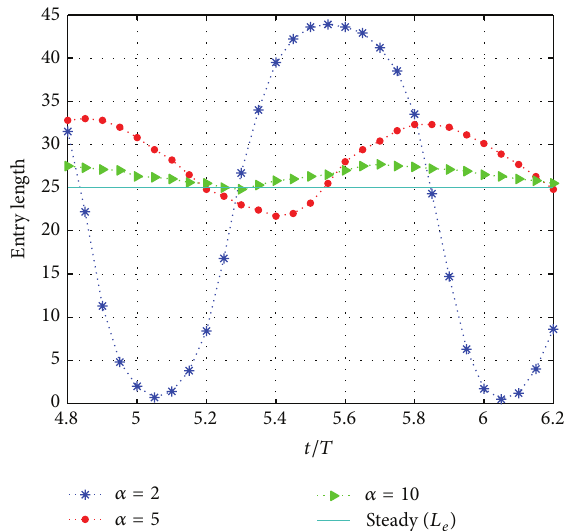
Figure 7: Unsteady entrance length with time for different Womer- sley number 𝛼 , when Re = 100 and Ha = 0.5 (where the solid line represents the steady entrance length).